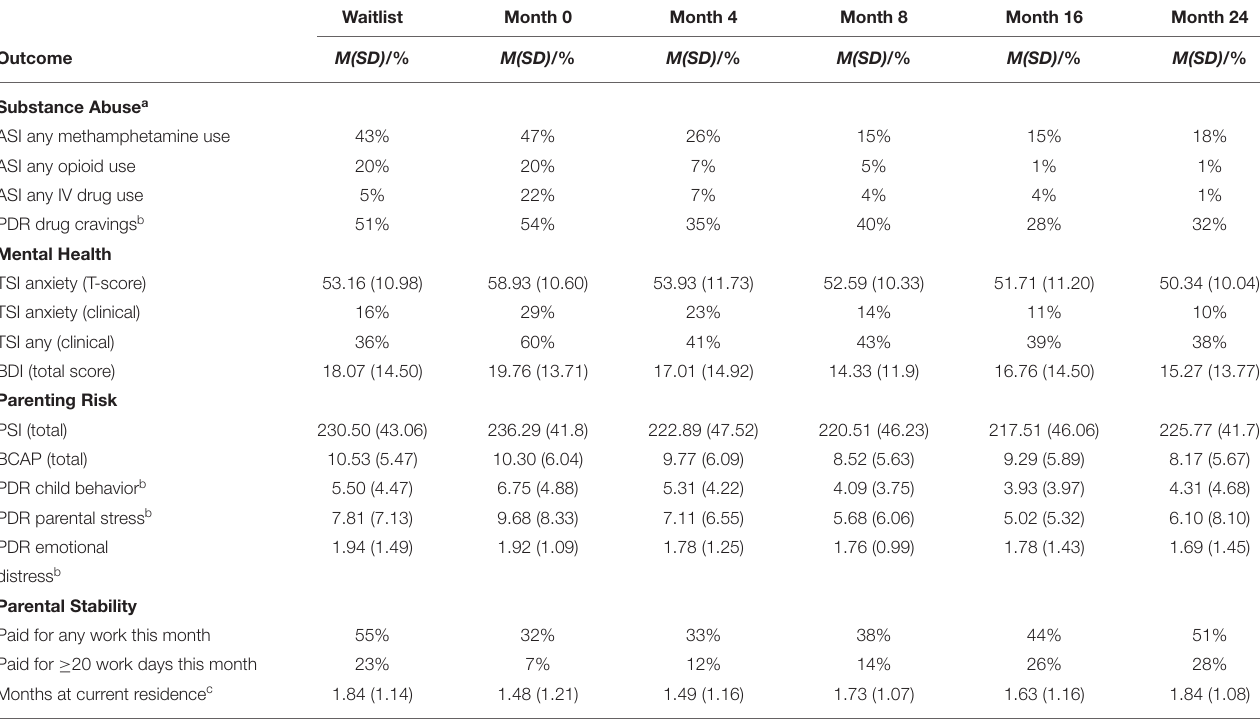
TABLE 1 | Descriptive statistics for substance abuse, mental health, parenting risk, and parental stability